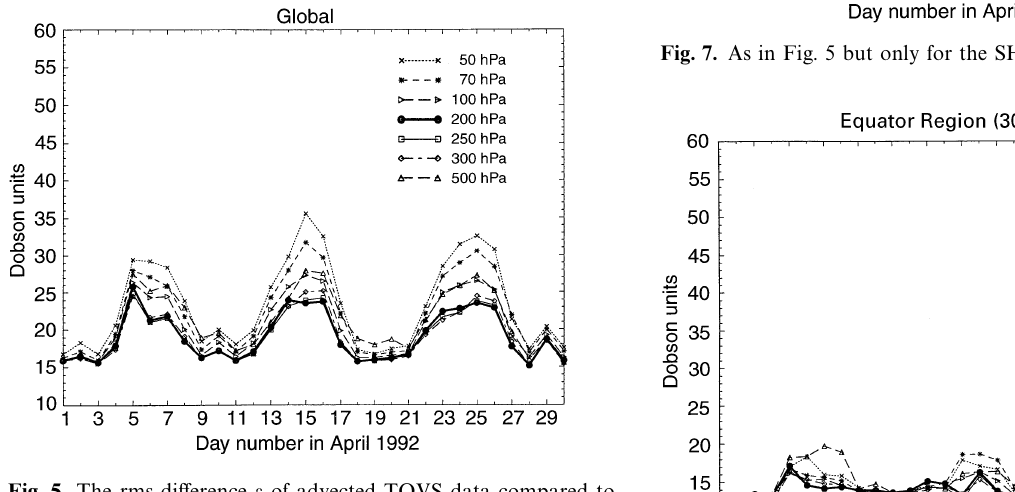
Fig. 5. The rms-difference (cid:101) of advected TOVS data compared to raw TOVS data (see Eq. 6) for the total globe, calculated for a wind field at the pressure levels 50, 70, 100, 200, 250, 300 and 500 hPa